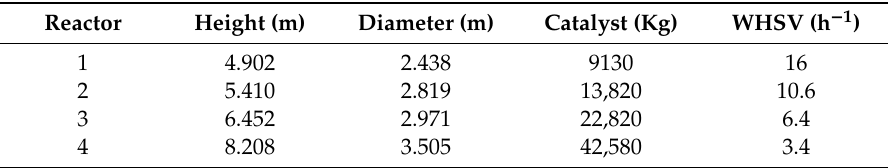
Table 4. Configuration of Commercial Catalytic Reformer [11].